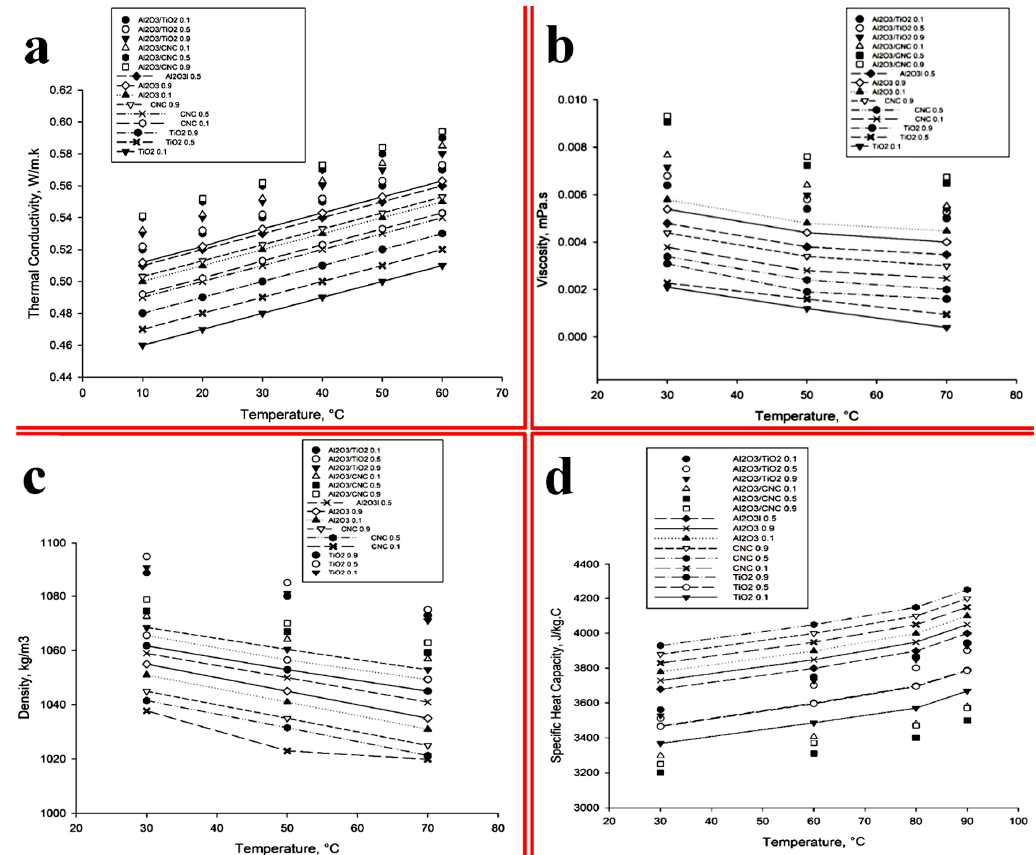
Figure 10. ( a ) Thermal conductivity of all the nanofluids vs. the temperature plot; ( b ) viscosity with respect to the temperature; ( c ) density comparison as a function of the temperature and the volume; and ( d ) comparison of the specific heat capacity of the mono and hybrid nanofluids with various volume concentrations.